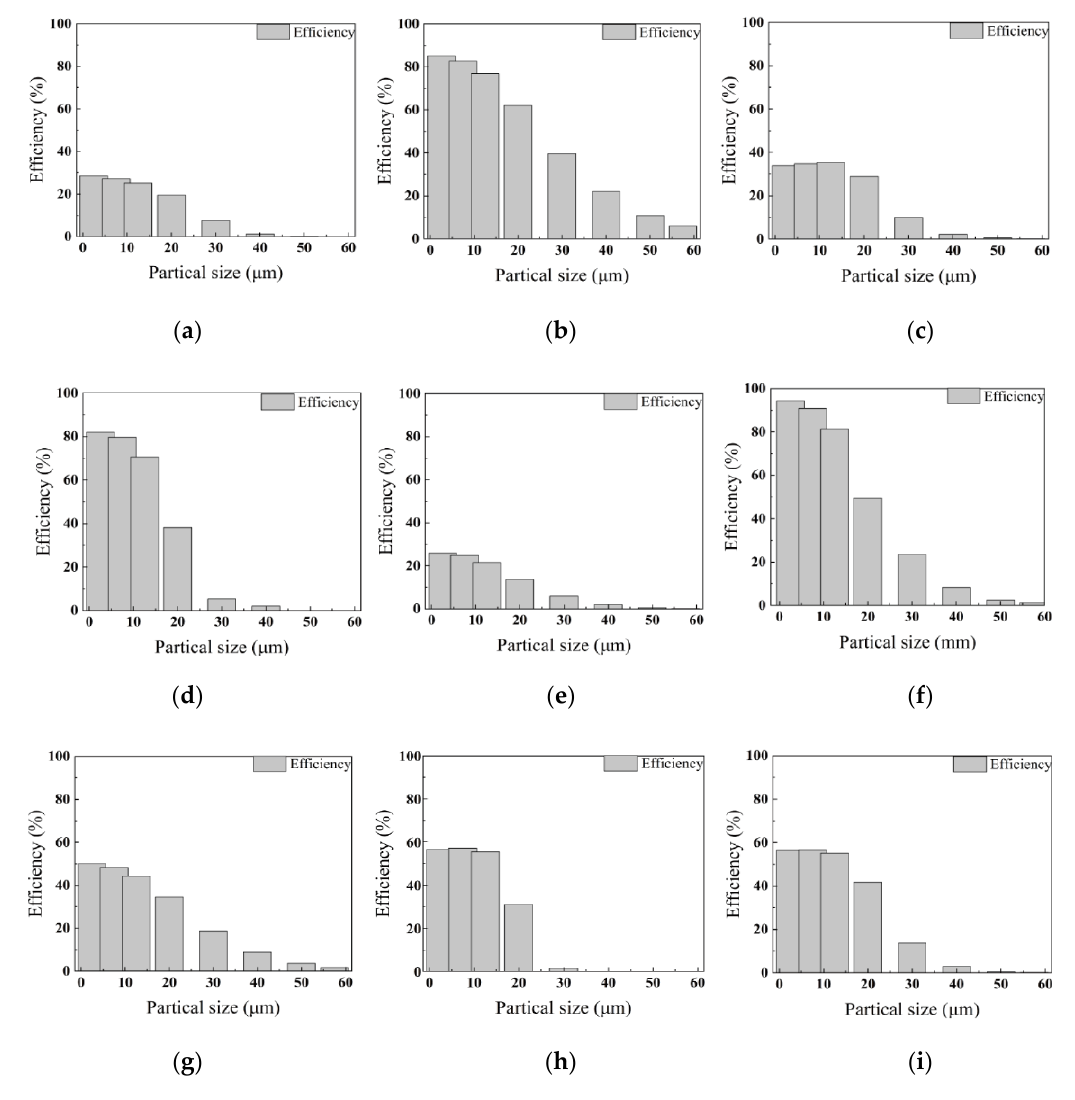
Figure 15. Internal overflow classification efficiency. ( a ) Test 1 ( b ) Test 2 ( c ) Test 3 ( d ) Test 4 ( e ) Test 5 ( f ) Test 6 ( g ) Test 7 ( h ) Test 8 ( i ) Test 9.